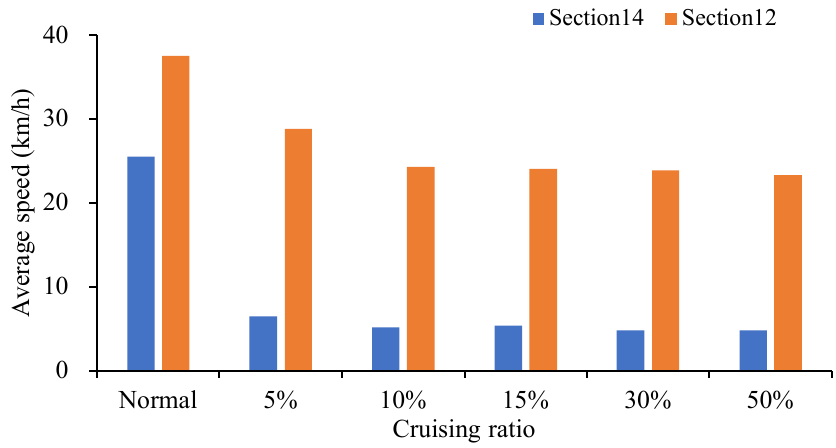
Figure 14. Comparison of average speed at Section 12 and Section 14.